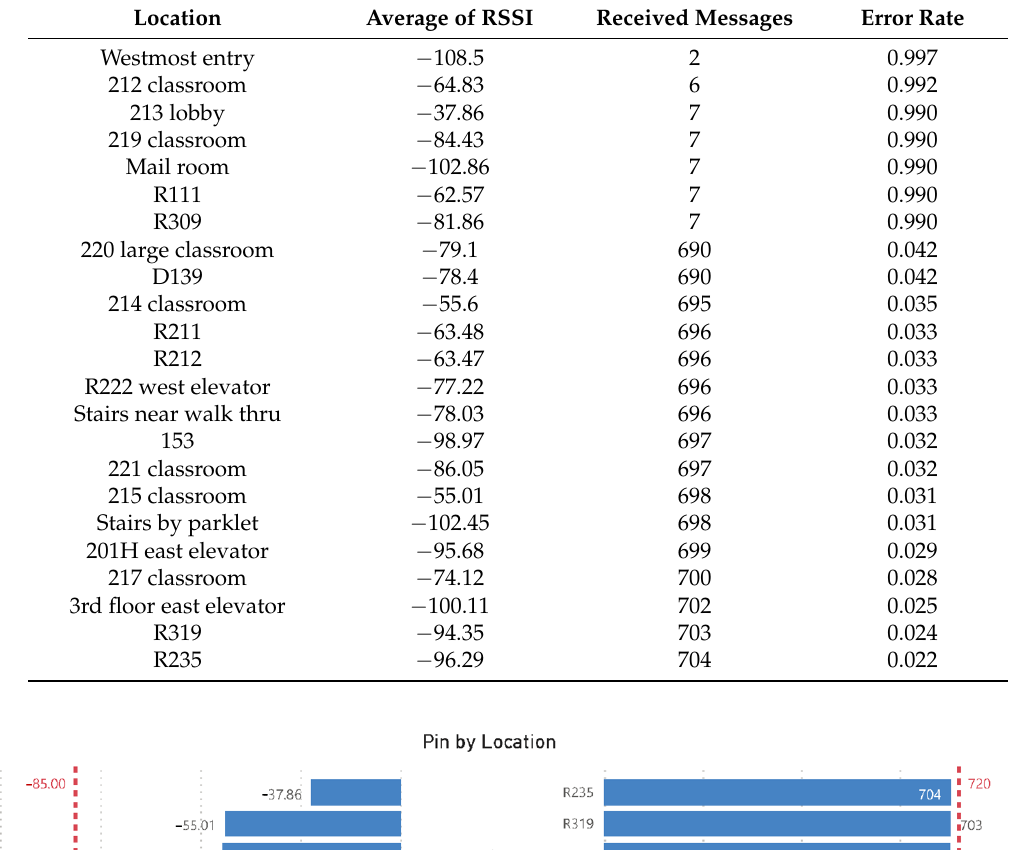
Table 4. Results of field test (order by error rate).